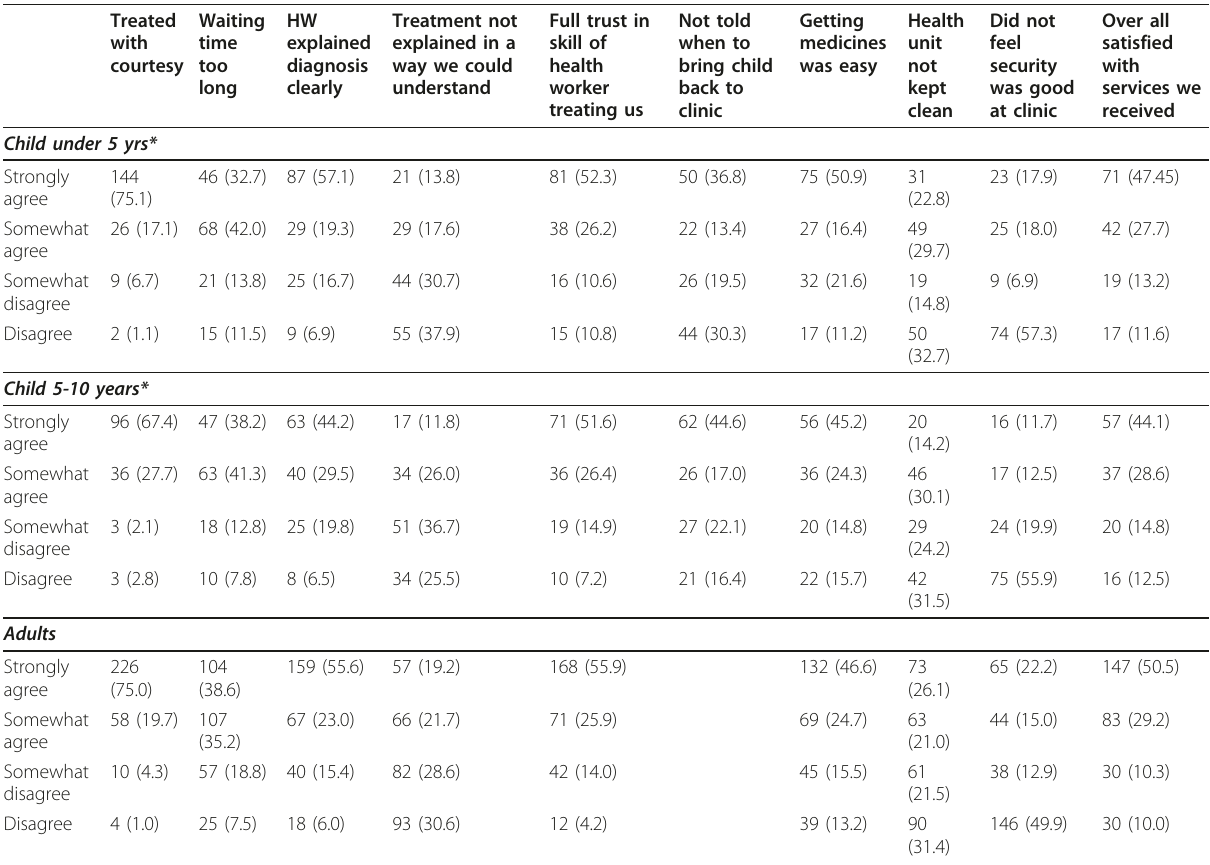
Table 1 Satisfaction with health care services (all sources) provided to adults or children (caretakers responding)